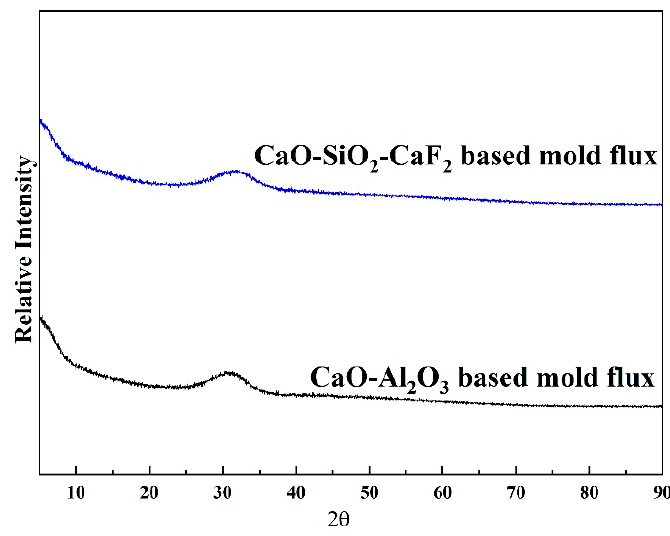
Figure 1. X-ray diffraction patterns of glassy mold fluxes of a CaO–SiO 2 –CaF 2 -based mold flux and a CaO–Al 2 O 3 -based mold